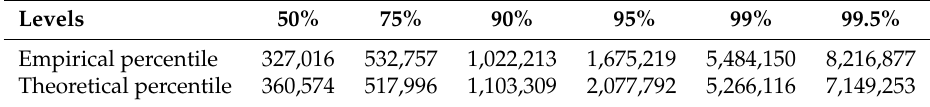
Table 8. Comparison between empirical and Lognormal–GPD–Gamma quantiles.